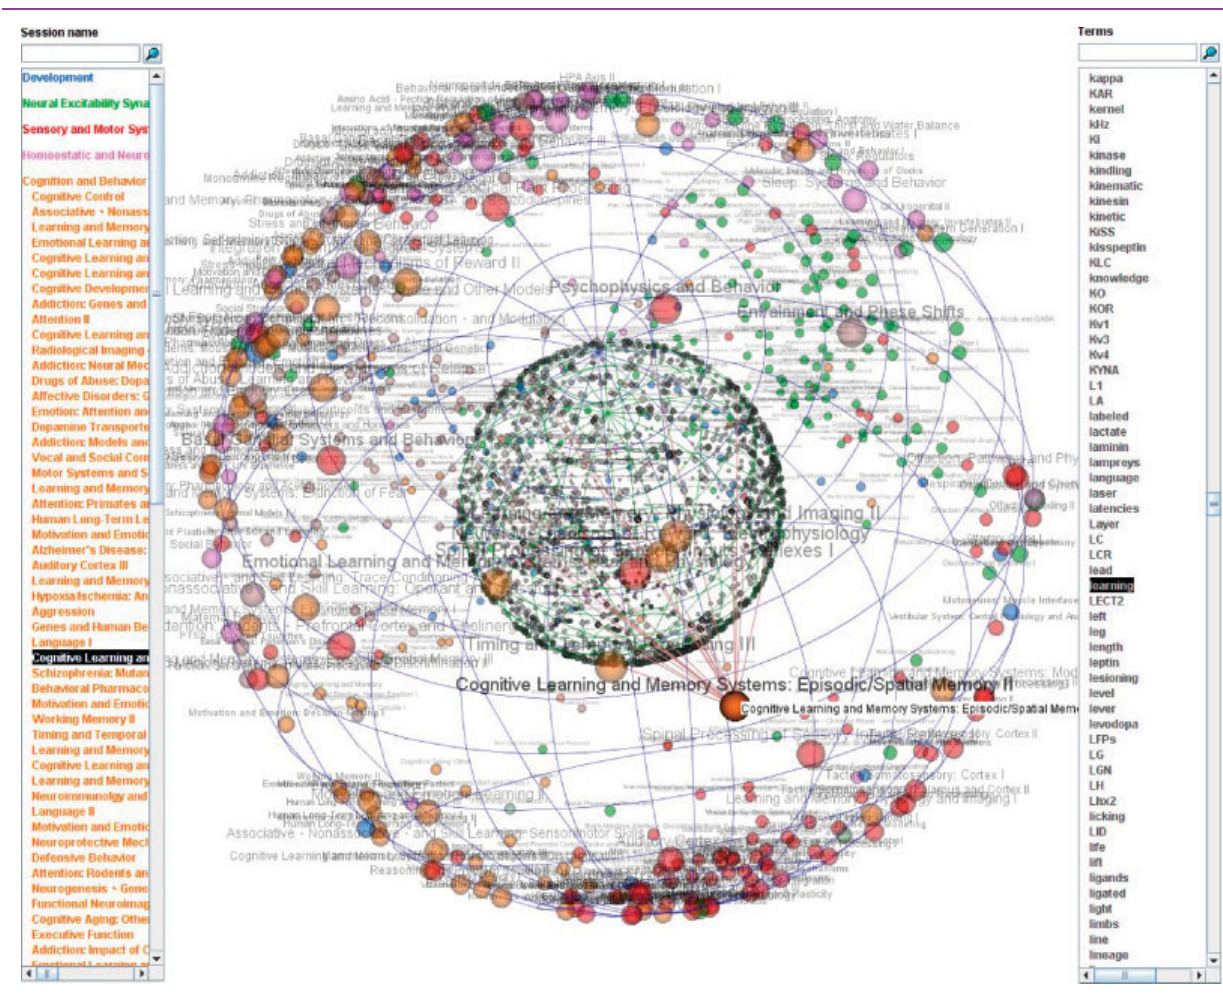
Figure 4. Society for Neuroscience 2006 Annual Meeting: a view of 650 poster sessions (outer sphere) and 2164 extracted terms (inner sphere). The nodes on the outer sphere are colored according to the session’s dominant theme. It can be seen that the nodes form some clusters according to their